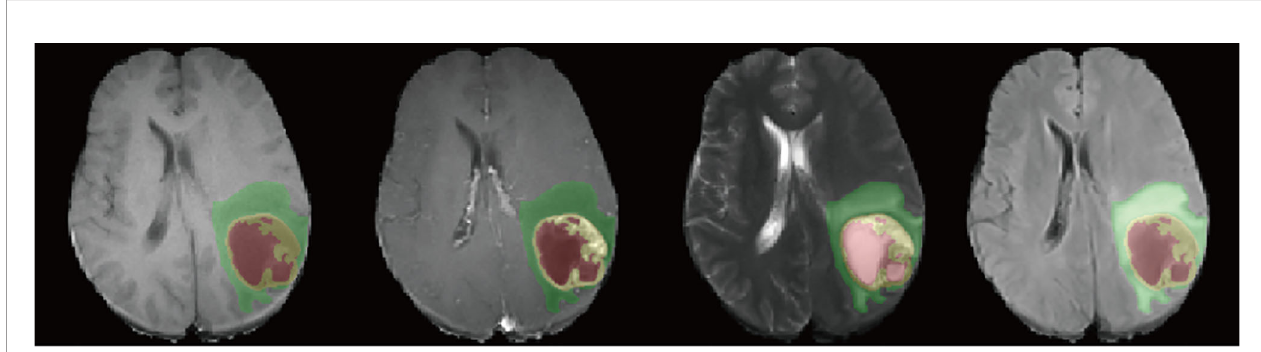
FIGURE 2 | Example of the segmentation results for patients from our center. The four image modalities were T1, gadolinium contrast-enhanced T1 (T1c), T2, and fl uid-attenuated inversion recovery (FLAIR), from left to right . Yellow represents the contrast-enhancing area. Red and yellow represent the tumor core (TC). The whole tumor (WT) contains all three